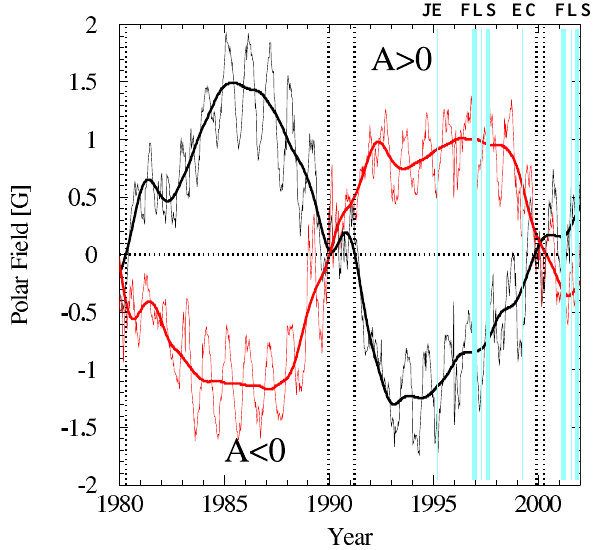
Fig. 3. Solar polar magnetic field strength (from http://quake. stanford.edu/ ∼ wso/) for the Southern (black) and Northern Hemi- sphere (red). The smoothed curves display the 20nHz low pass filtered values. The times summarized in Table 1 are marked by shading. The dotted lines indicate time periods of the solar mag- netic field